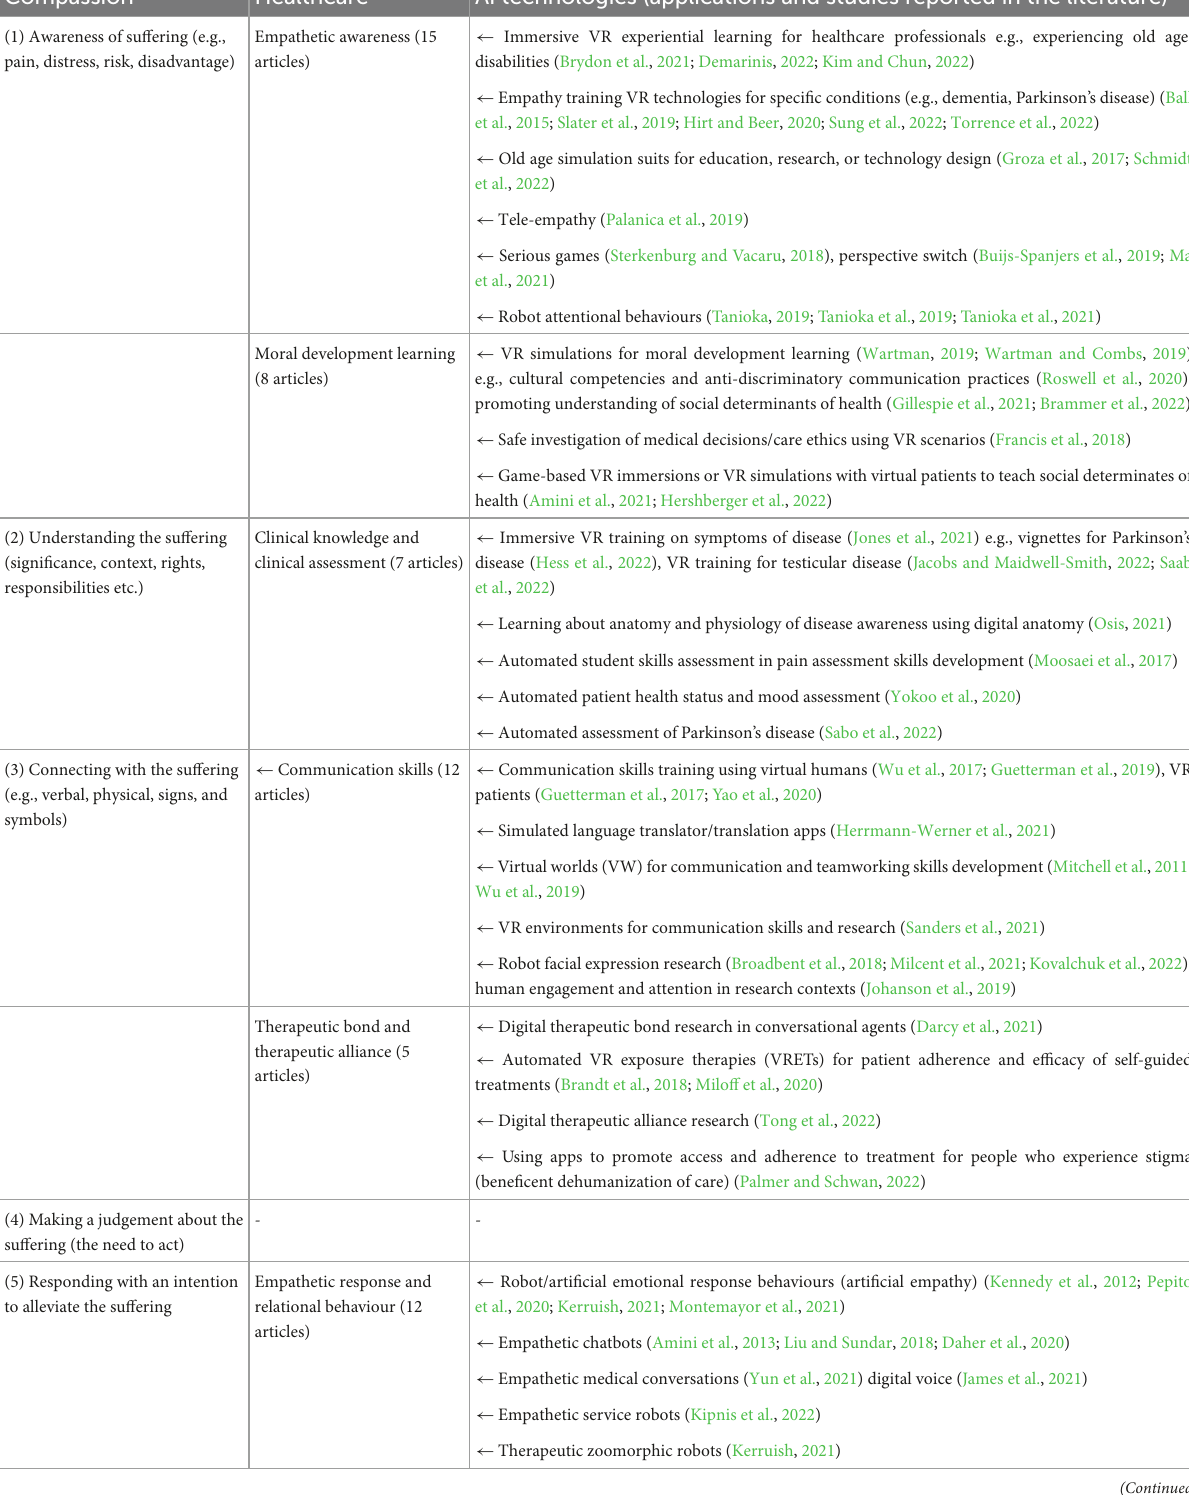
TABLE 4 Artificial intelligence (AI) technologies mapped to compassion in healthcare. Compassion